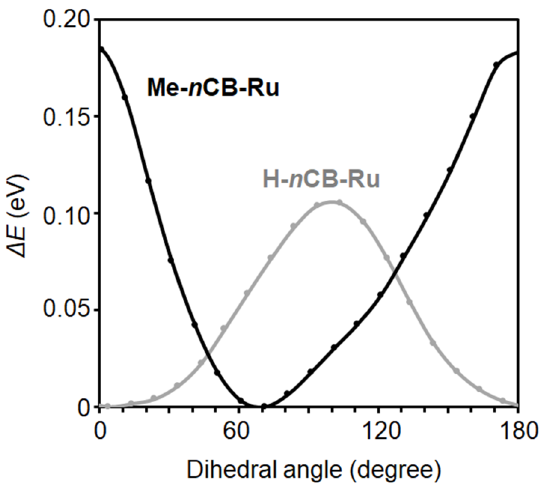
Figure 5. Energy level diagrams of the S 0 state for each complex upon rotation of the nido -carborane units.